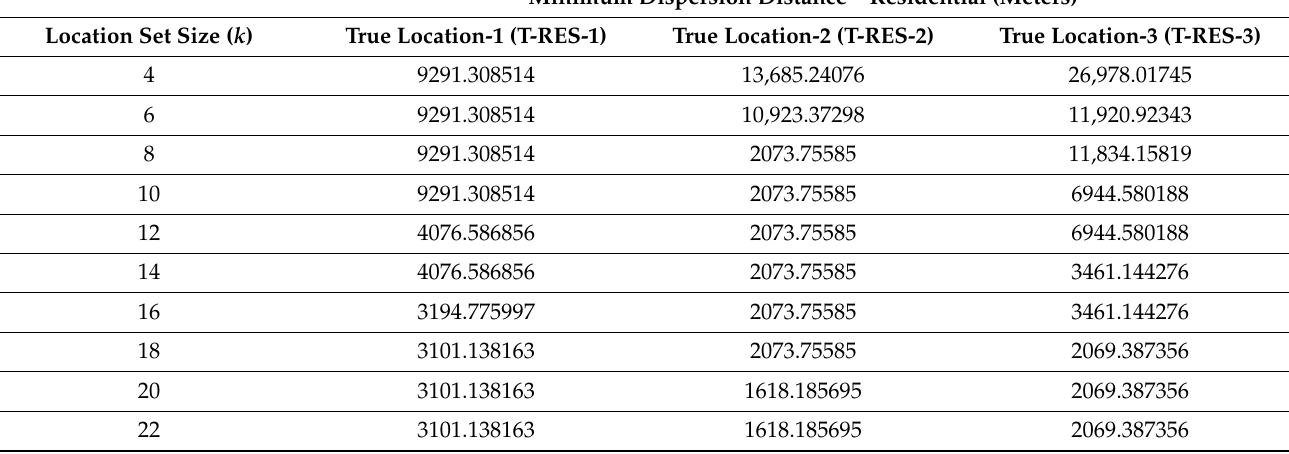
Table 3. Showing physical dispersion of residential locations in a location set of different sizes ( k ) of the three input